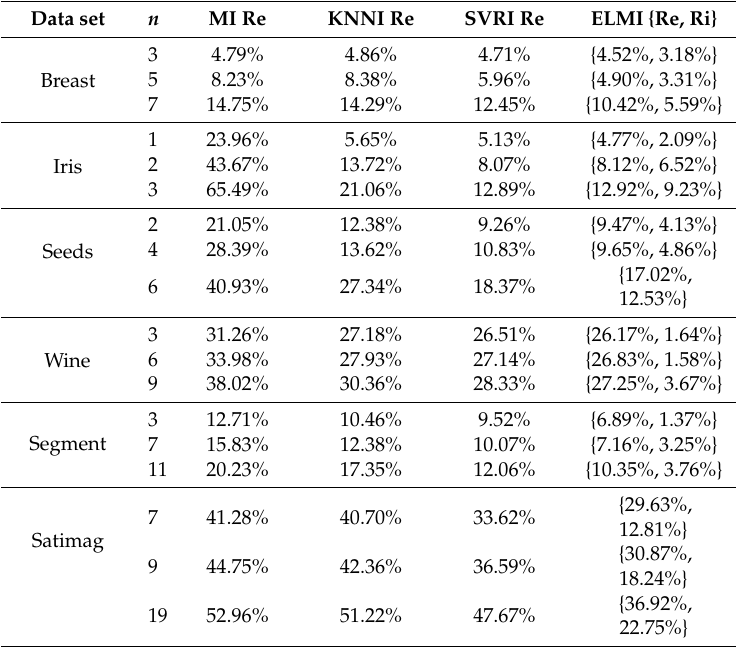
Table 2. The classification results for different data